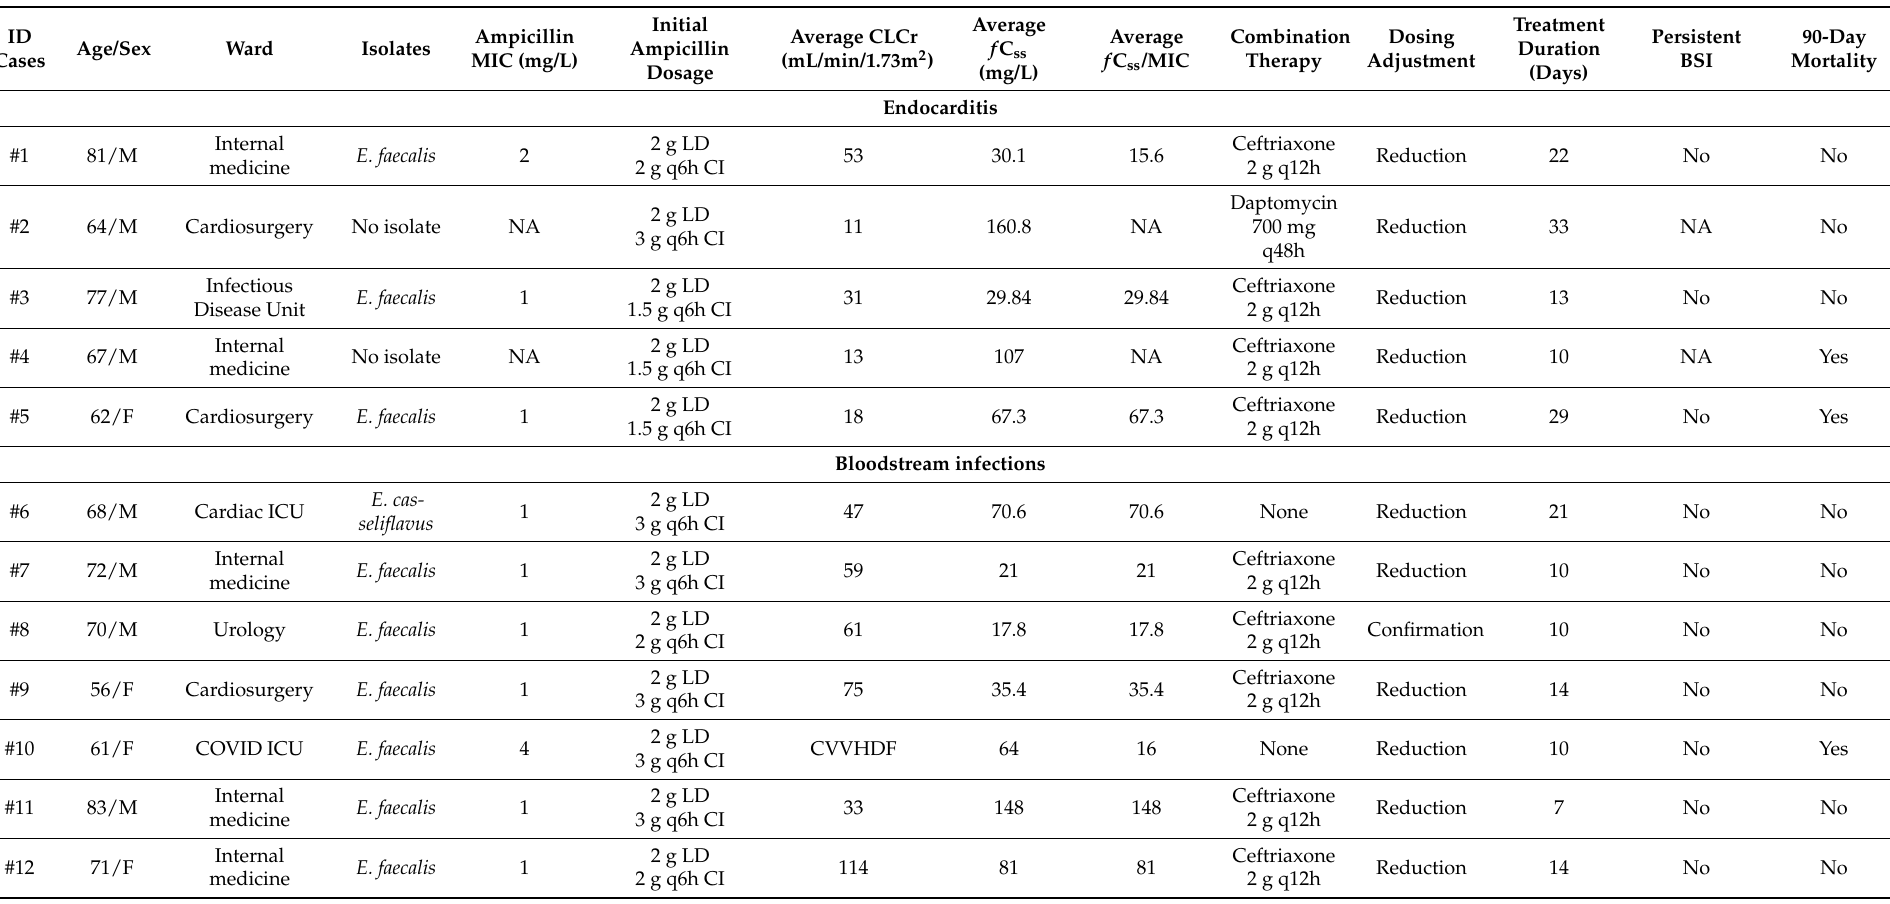
Table 1. Demographic and clinical features of patients with documented or suspected enterococcal infections treated with continuous infusion